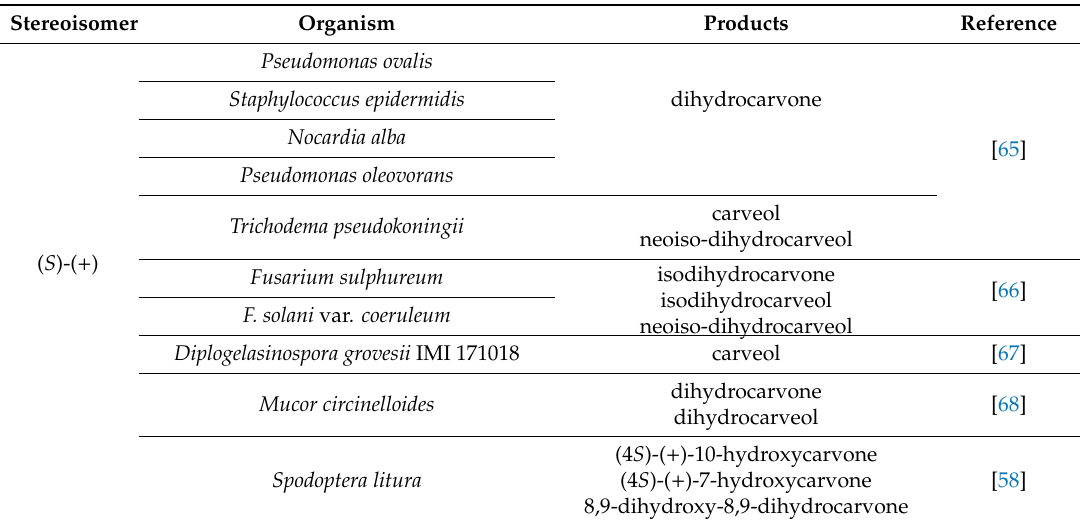
Table 8. Biotransformation of carvone.